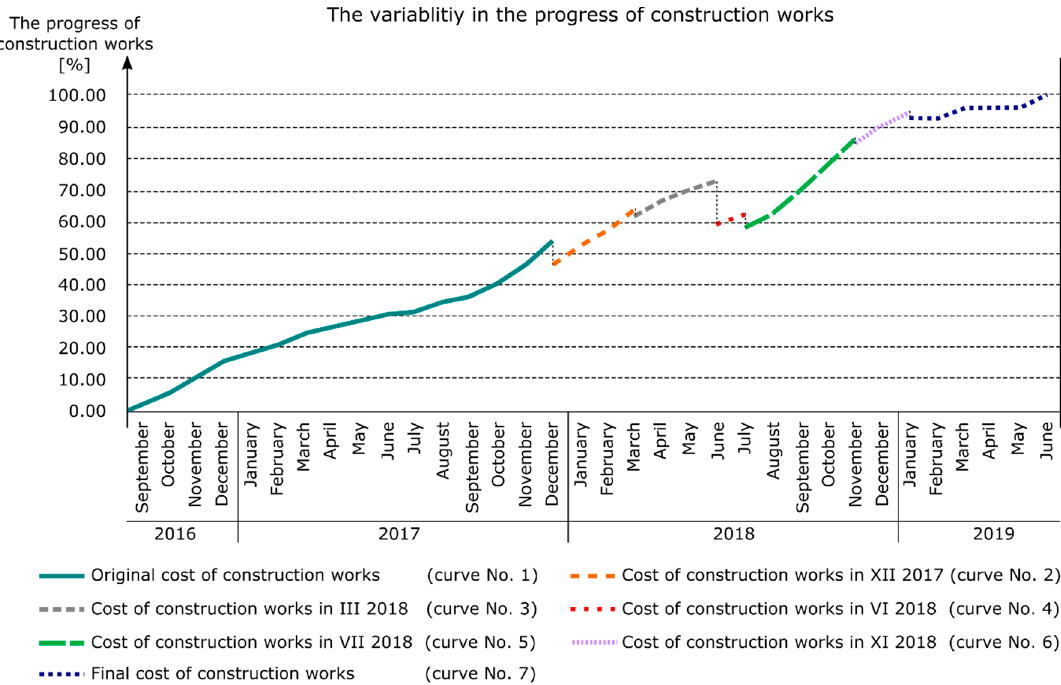
Figure 3. Variability in the progress of construction works as a result of updating the work and expenditure schedule of the hotel facility (own elaboration).